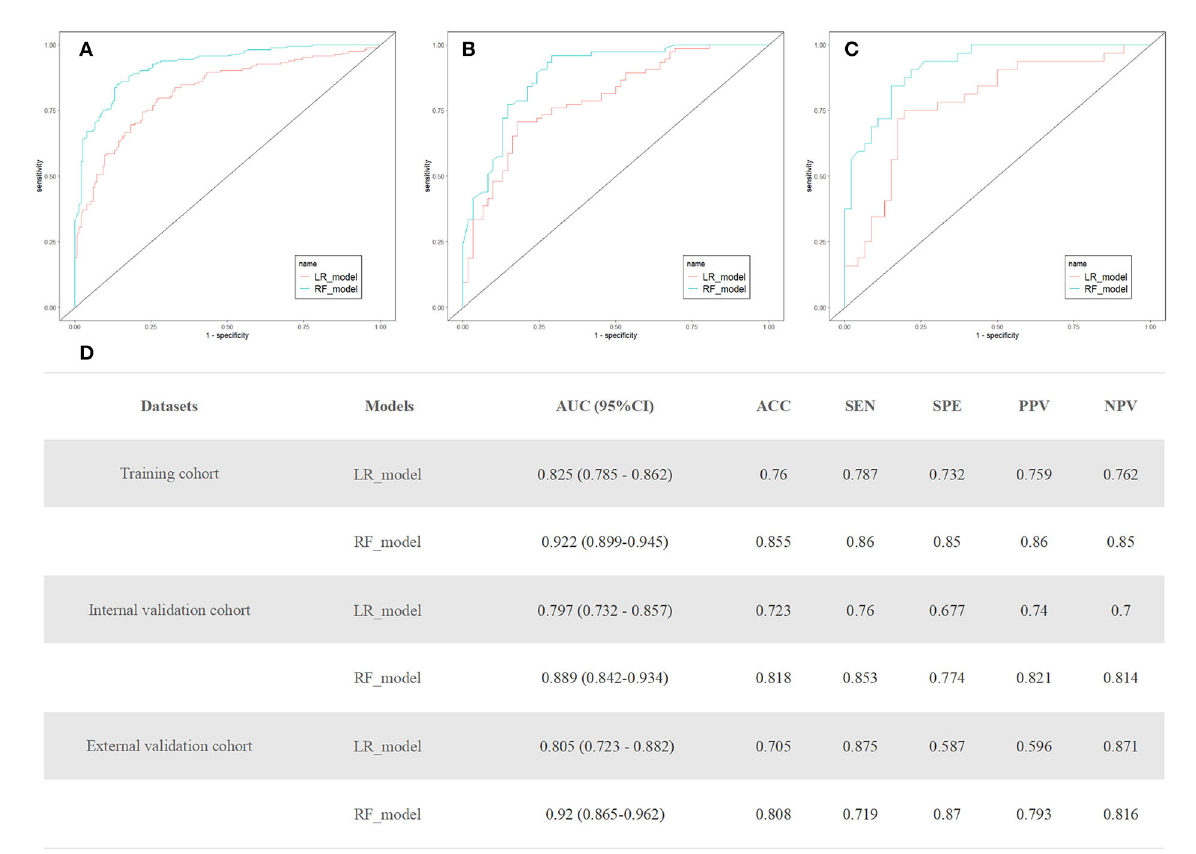
FIGURE3 (A–C) Receiver operating characteristic (ROC) curves of the random forest and logistic regression models in training, internal, and external validation cohort. (D) The performance of the random forest and logistic regression models to predict the rupture of small middle cerebral artery (MCA) aneurysms. AUC, area under the receiver operating curve; CI, confidence interval; ACC, accuracy; SEN, sensitivity; SPE, specificity; PPV, positive predictive value; and NPV, negative predictive value.